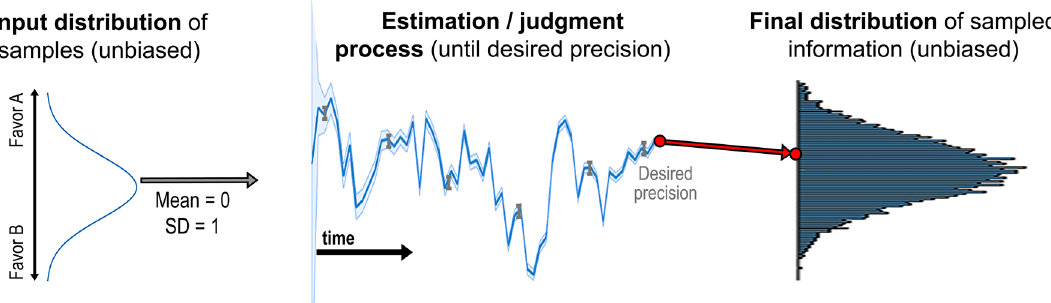
Figure 2. Illustration of a precision-based judgment process, where the goal is not to select one side over the other (as in Fig. 1) but to meet a criterion level of estimation of the mean estimate. As a result, the judge is incentivized to gather more information to form an estimate after gathering extreme information, and incentivized to stop after gathering moderate information. Following this optimal strategy, the distribution of sampled information across a population of decision makers (right side of Fig. 2) will correspond closely to the input distribution (left side of Fig. 2). Posing the